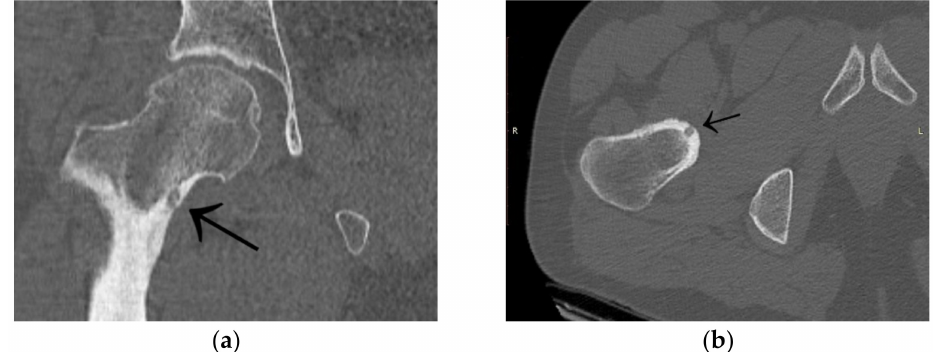
Figure 2. CT scan showing a focus of OO (arrows) in the right femoral neck. ( a ) Frontal CT scan; ( b ) Transverse CT